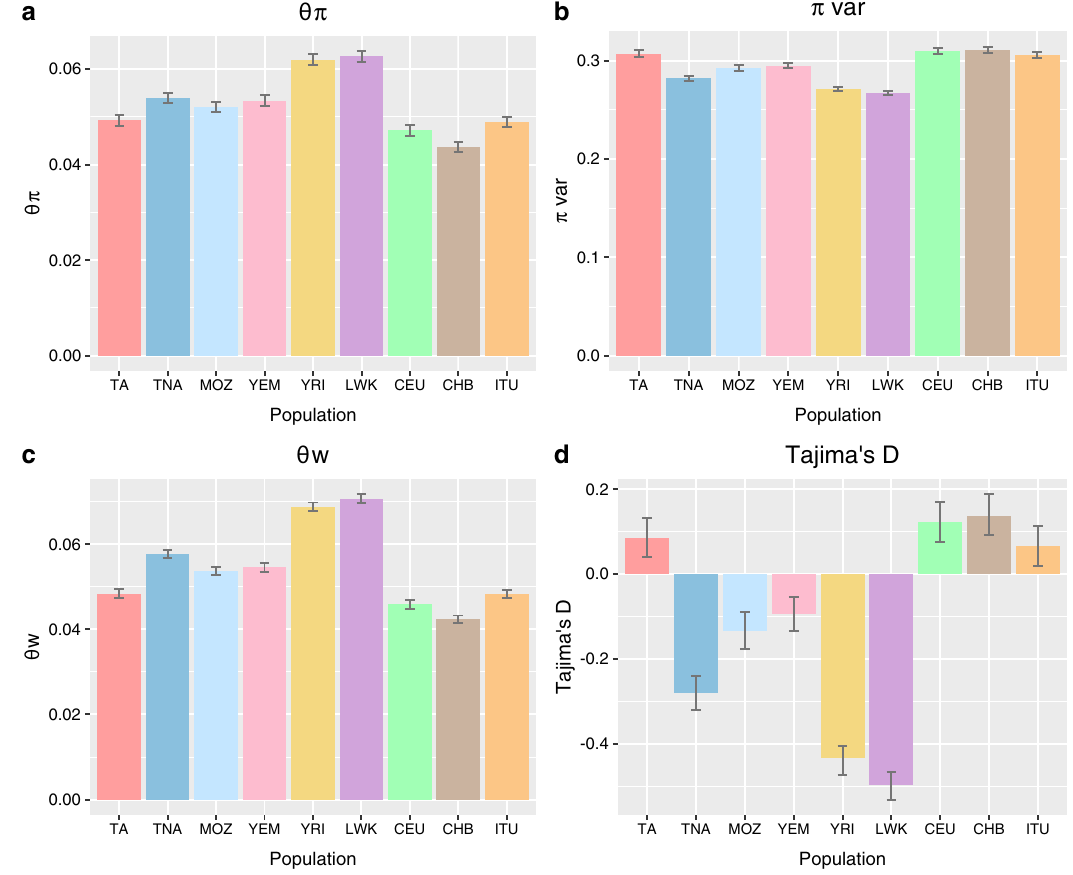
Figure 4. Genetic diversity indexes. ( a ) Pairwise nucleotide diversity θπ. ( b ) Nucleotide diversity for the variable sites πvar. ( c ) Watterson’s estimator θw. ( d ) Tajima’s D. Error bars represent the 0.025 and 0.975 quantiles obtained by bootstrapping by site 1000 times, dividing the exome data into 1000 blocks and performing bootstrap resampling of blocks 1000 times. Population names abbreviated as in Fig.